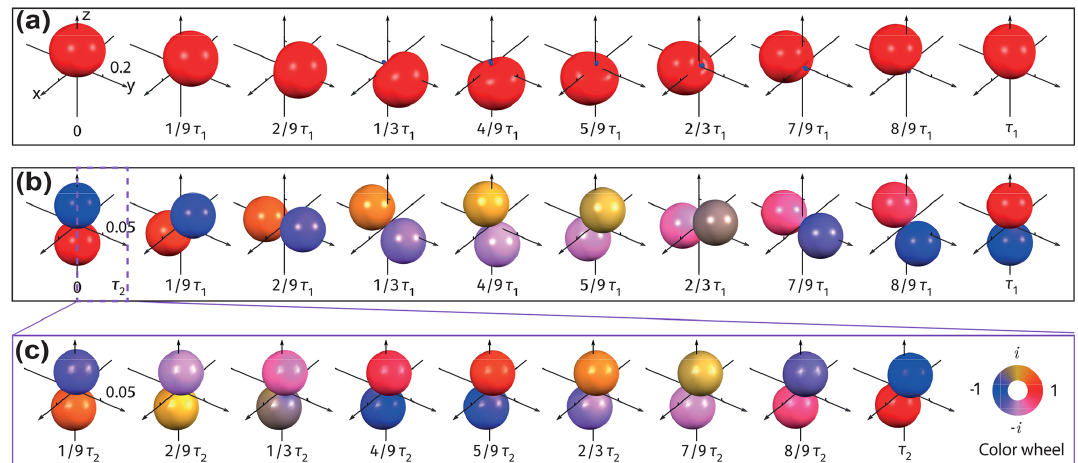
Figure 9. Visualizations of spin dynamics in an AX system ( 1 H– 13 C nuclear pair) during the ZULF experiment using the multipole tensor operator-based DROPS approach. Conditions are the same as those used in Fig. 5. Panels (a) – (c) show the surfaces representing the spin evolution during the ZULF experiment of (a) the (1 , 1) block and (b) the (1 , 0) block. The inset shows the evolution of the surface plotted in panel (b) over a shorter timescale of τ 2 . Colors of surfaces denote the phase of the calculated radius (Eq. 7) according to the color wheel shown at the bottom